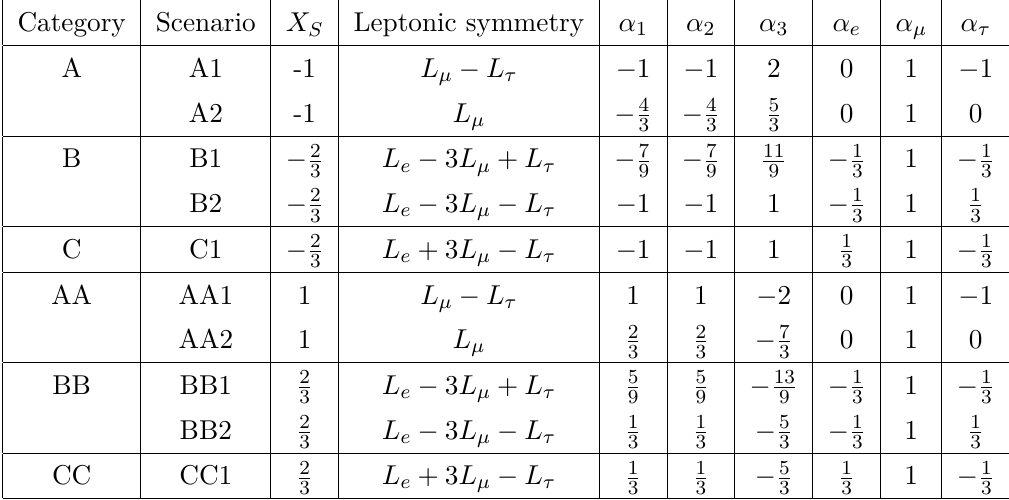
Table 3 . The scenarios indicated by our bottom-up construction, categorized by the charge X S and α . Categories A, B and C, with negative X e we include the categories AA, BB and CC here, which have positive X